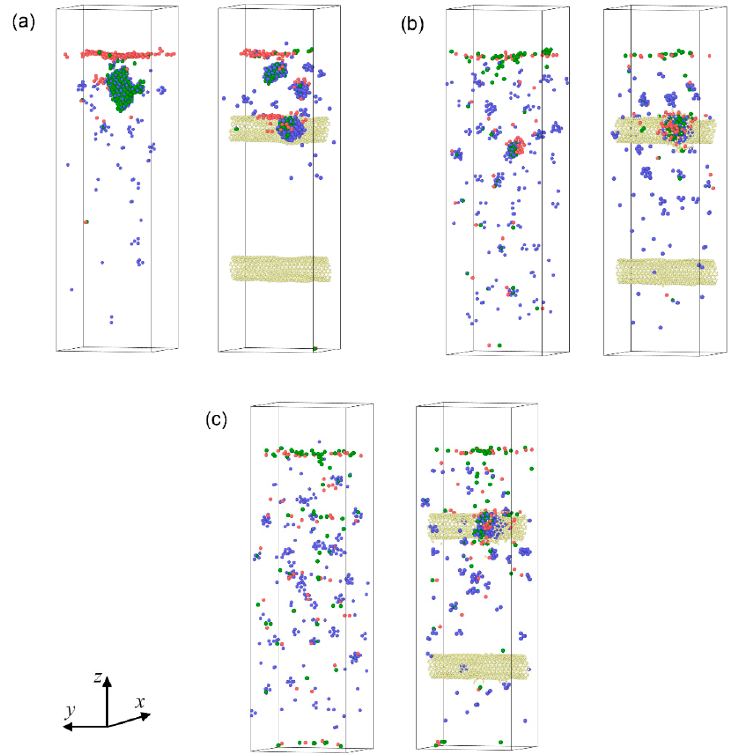
Figure 7. Point defects distribution in the Fe matrix and the SWCNT/Fe composite, t = 1200 ps. The left and right sides of ( a ), ( b ), and ( c ) represent the Fe matrix and the SWCNT/Fe composite, respectively. The red and green balls denote interstitials and vacancies, respectively. The blue and yellow balls denote He atoms and C atoms on the carbon nanotubes, respectively. The incident energies of the He atoms were ( a ) 300 eV; ( b ) 600 eV; and ( c ) 900 eV.